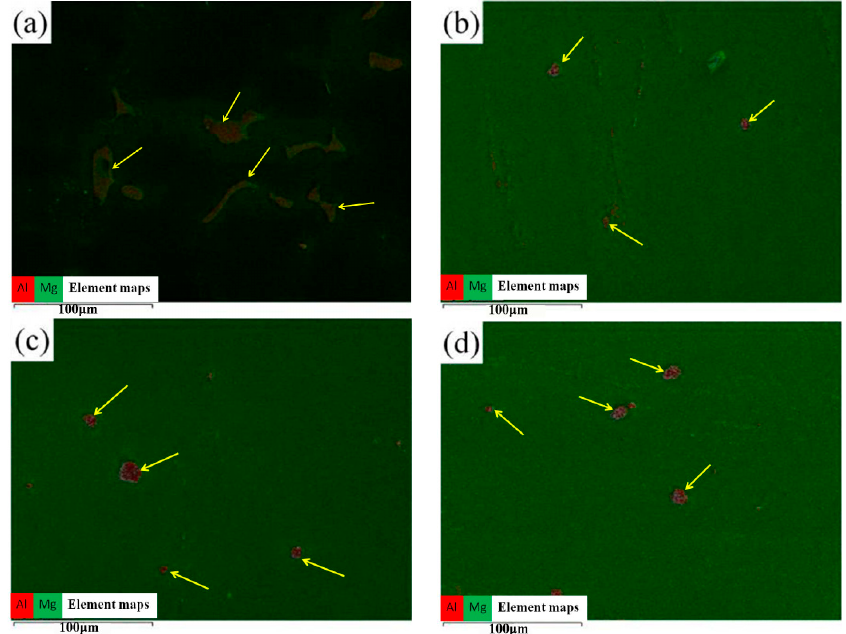
Figure 4. Element maps of Mg and Al overlapped on energy dispersive spectroscope (EDS) images: ( a ) 1#, ( b ) 2#, ( c ) 3# and ( d ) 4# (arrows indicate β -phase particles).